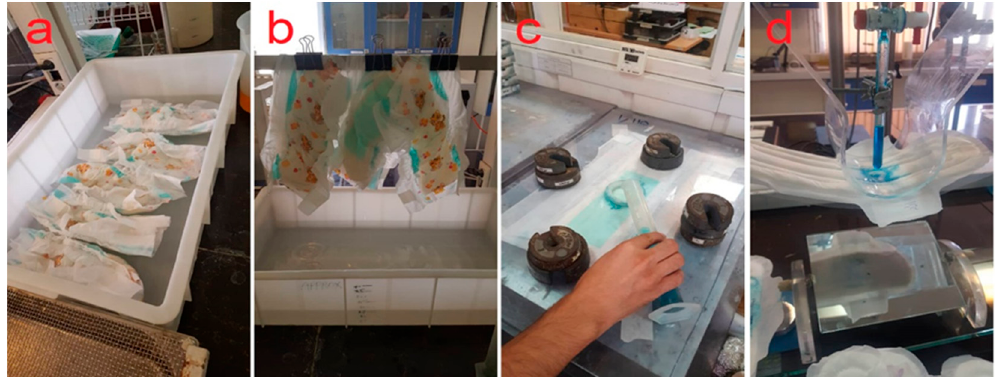
Figure 12. Experimental activity for testing of baby diapers and sanitary napkins. Absorption capacity test of baby diaper pad ( a , b ), rewet and absorption time of baby diaper pad ( c ), absorption capacity test of the sanitary napkin pad ( d ).